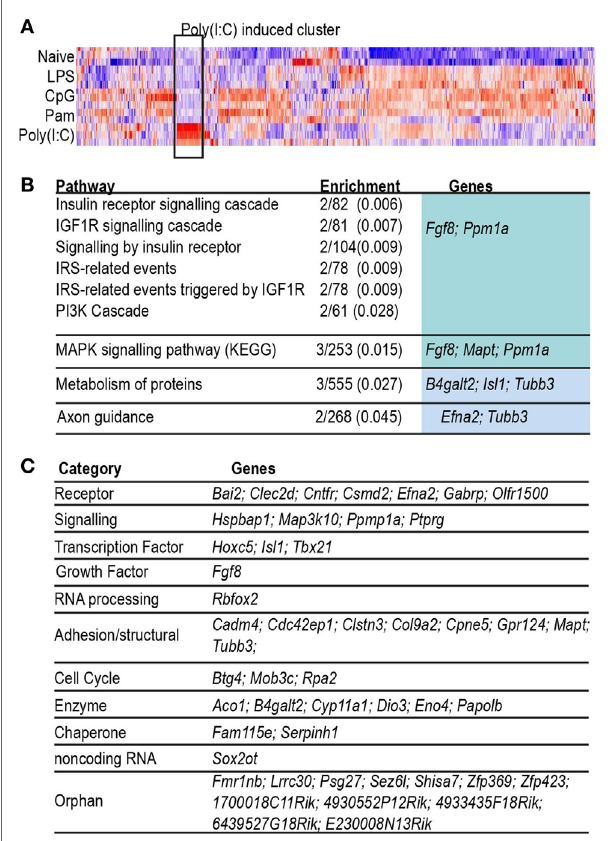
FigUre 3 | Characterization of probes induced only by Poly(I:C). (a) Heat map (Pearson correlation) of combined list of top 500 acutely induced genes per acute condition. Color indicates row z -score, ranging from − 2 (blue) to 2 (red). Highlight box indicates cluster of probes highly induced only in Poly(I:C). (B) Table of Reactome pathways enriched (adjusted p < 0.05) in genes induced uniquely by acute infection with Poly(I:C). Enrichment: number of genes in test list/number of genes in pathway (adjusted p -value). (c) Table of genes grouped by biological